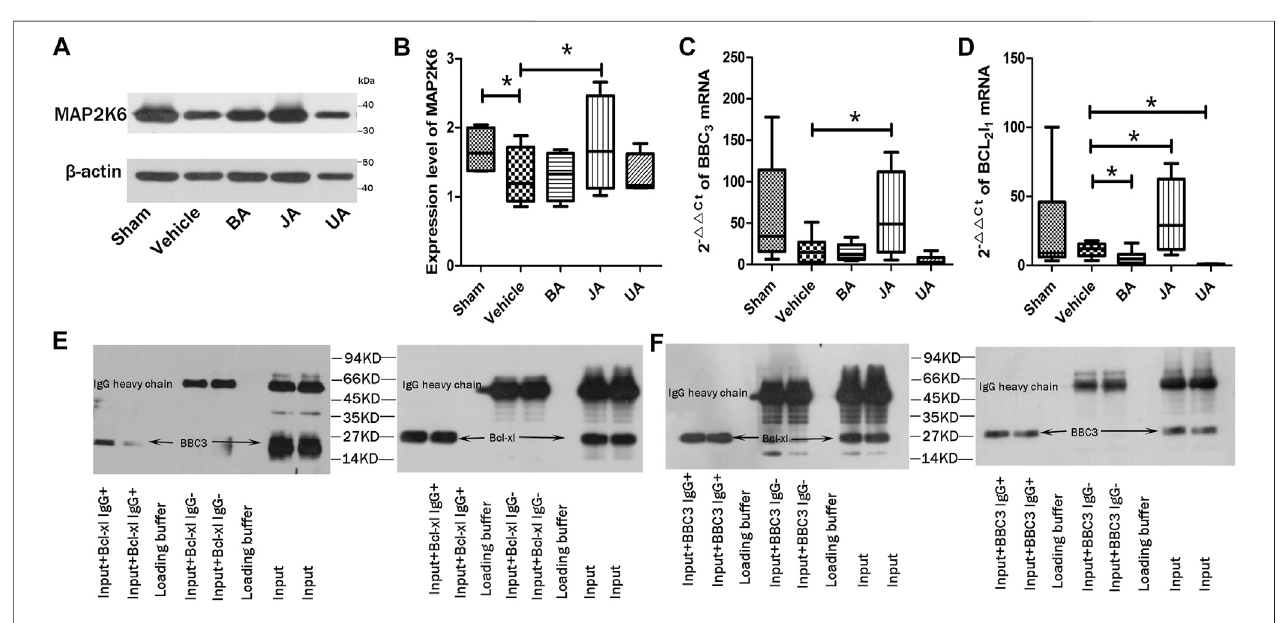
FIGURE 5 | Validation of core protein, genes, and interaction in PMP. (A and B) show expression of MAP2K6 of Western blot in distinct groups. (C and D) are relative contents of BBC3 and Bcl2l1 among different groups. * p < 0.05 . (E and F) represent the co-immunoprecipitation results of BBC3 and Bcl-xl.